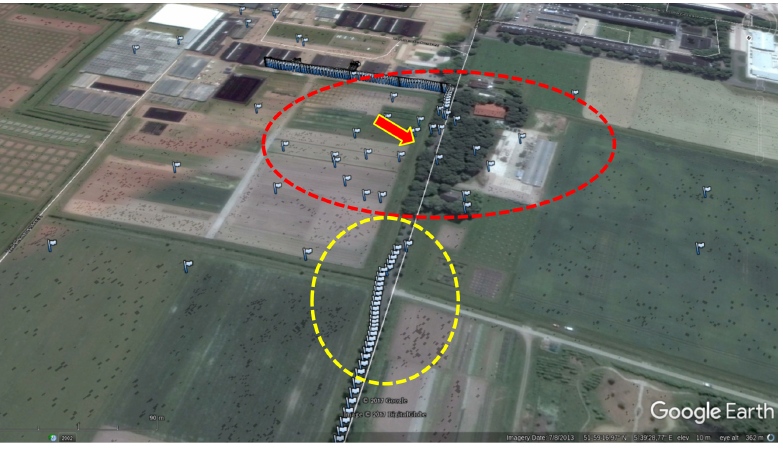
Figure 11. Detail of TPSD WARTK trajectory: convergence (under yellow ellipse) of the rover position after leaving the canopy (red